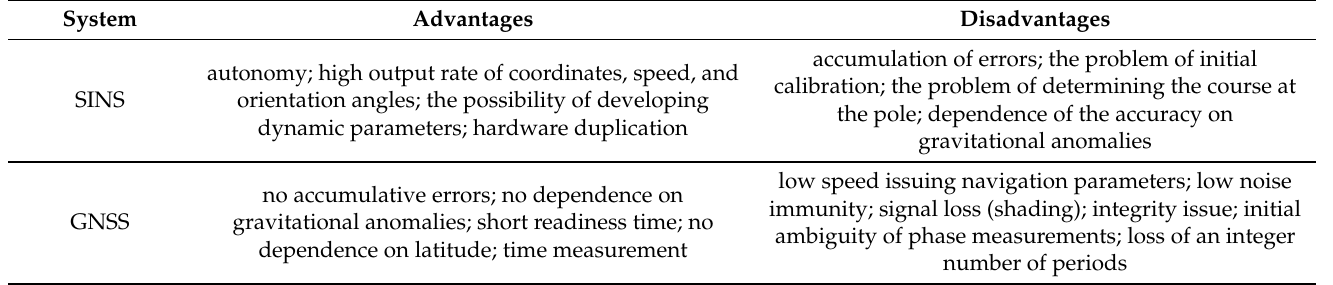
Table 3. Comparison of the properties of the SINS and the GNSS.